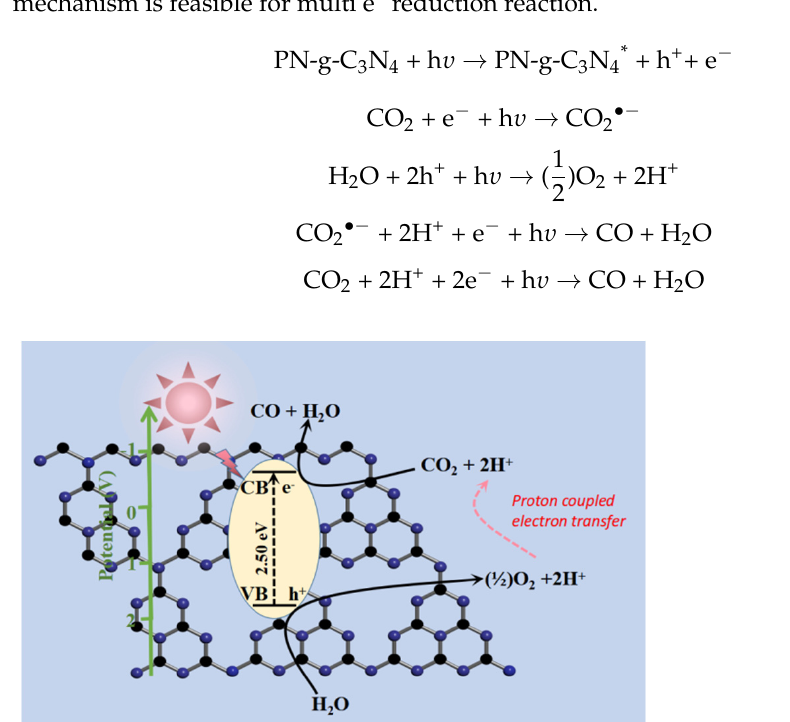
Figure 10. A possible photocatalytic CO 2 reduction mechanism for CO